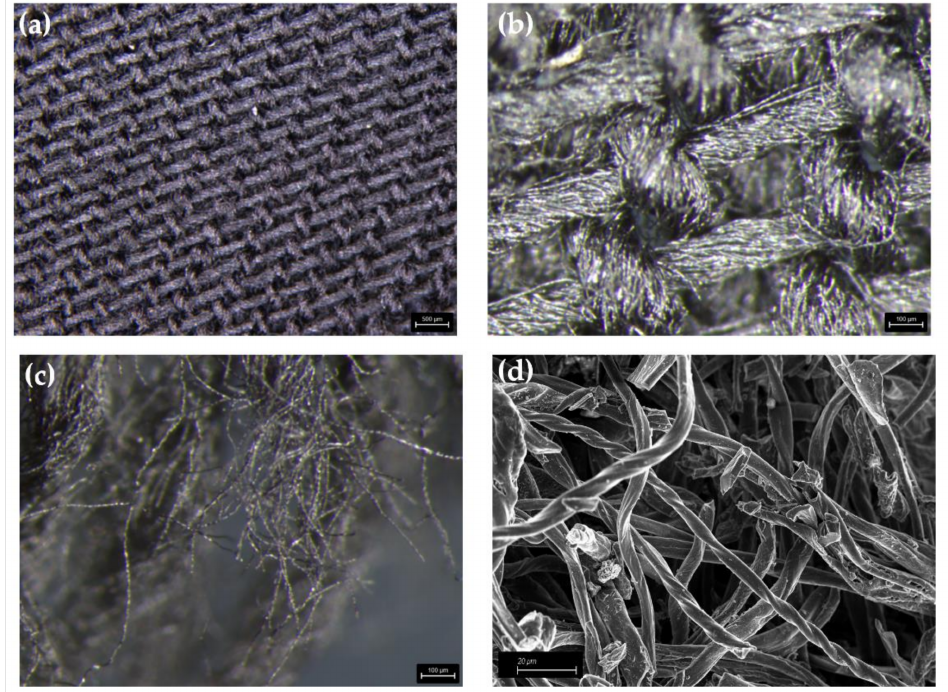
Figure 1. Microscopy analysis of WCB ( a , b ) surface and ( c ) edges prior to grinding, and ( d ) FESEM capture of WCB after